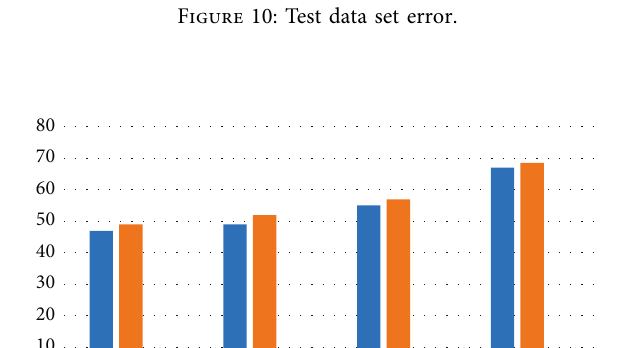
Figure 10: Test data set error.